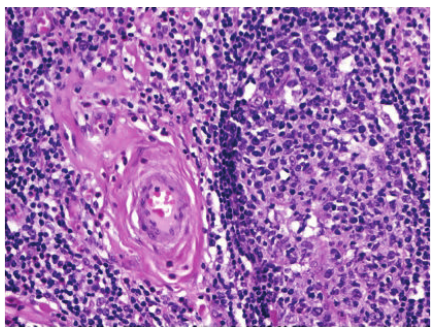
Figure 7: Perivascular fibrosis is seen involving scattered vessels (H&E,